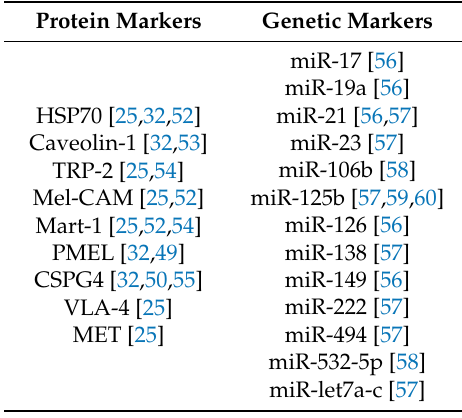
Table 1. Potential melanoma-derived EV markers for diagnosis, as described in this